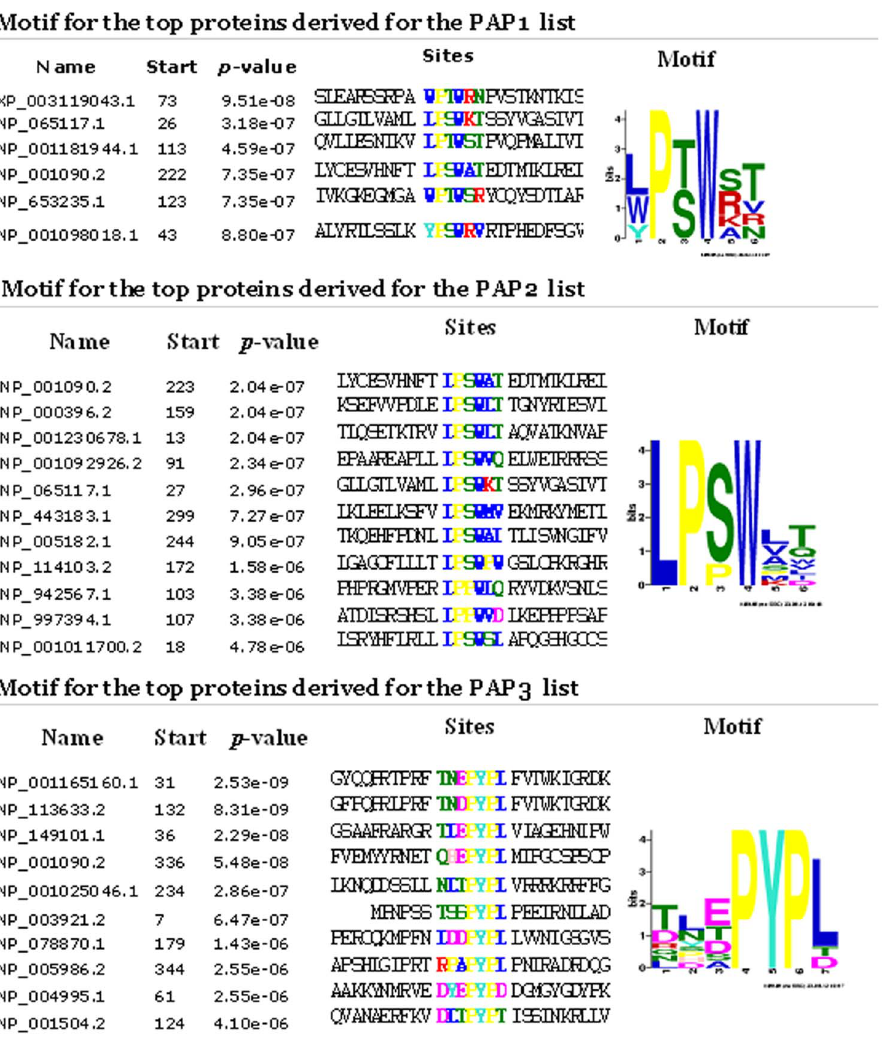
Figure 3. Motifs identified by MEME software for the top candidate antigens selected for the PAP1 and PAP3 antisera. Motifs for the antigens are related to the motifs identified for the corresponding top 500 the most abundant peptides.